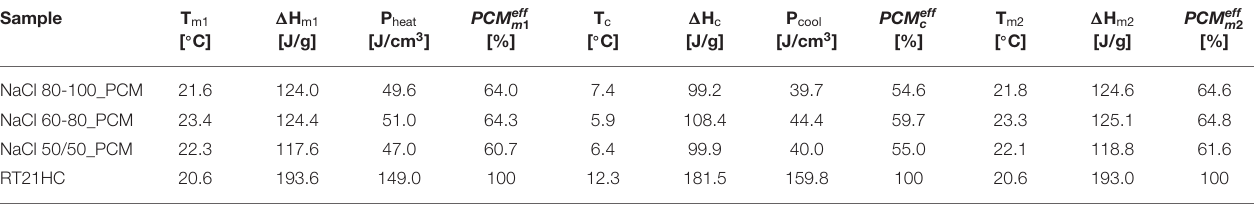
TABLE 3 | Selected data of temperature/enthalpy in a heating-cooling-heating cycle performed in differential scanning calorimetry (DSC) at 10 ◦ C/min. Sample